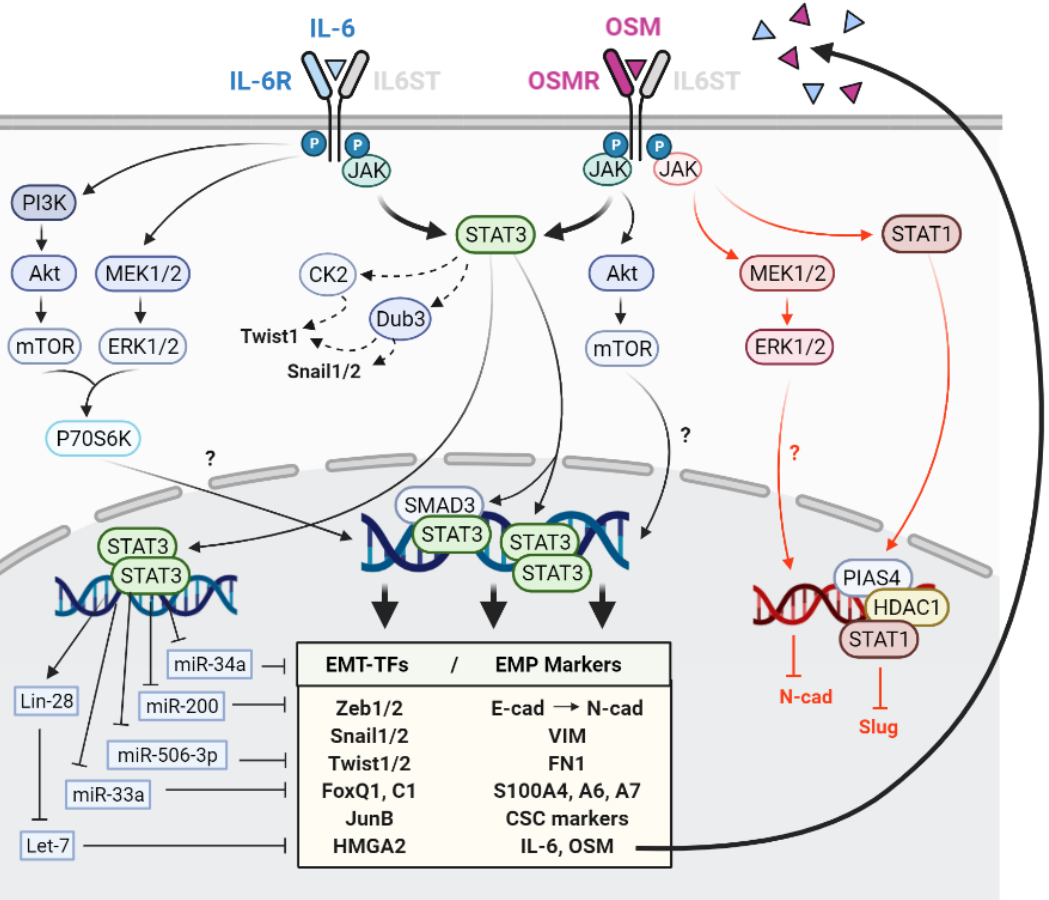
Figure 1. Schematic representation of the effects of interleukin 6 (IL-6) and oncostatin M (OSM) in epithelial–mesenchymal plasticity (EMP) and the downstream pathways and mediators involved. Black and red colours indicate pro and anti-EMP functions, respectively. T arrows indicate inhibition. Dashed arrows indicate EMP promotion by EMT-TF protein stabilisation. EMT-TFs: Transcription factors involved in EMP.